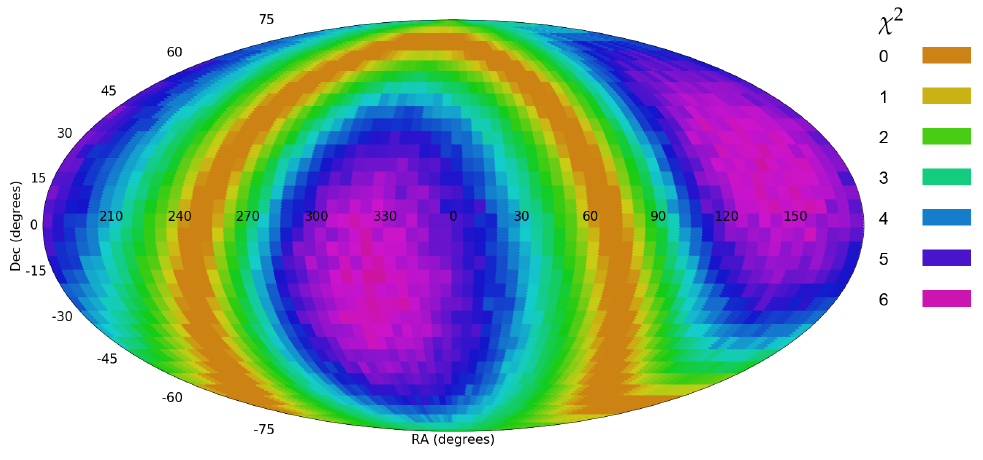
Figure 10. The χ 2 probability of the dipole axis when the dataset in limited to galaxies with exponen- tial g magnitude greater than